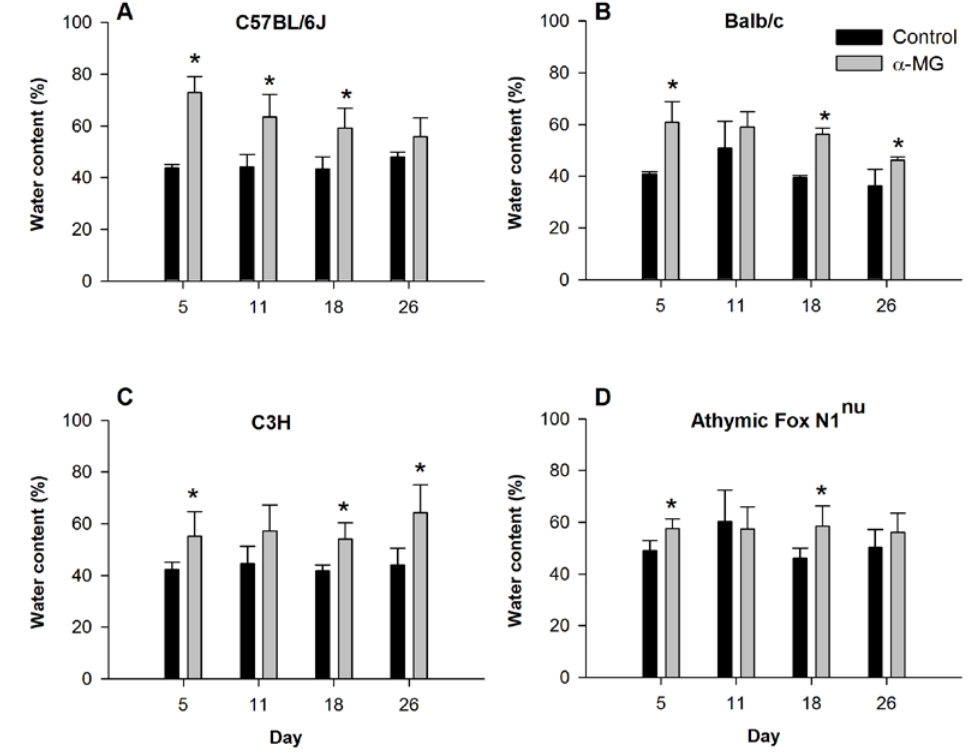
Figure 1. Dietary α-mangostin increases fluid content in stool. Water content in stool excreted by ( A ) C57BL/6J; ( B ) Balb/c; ( C ) C3H; and ( D ) Athymic FoxN1 nu mice during feeding of control diet or diet with α-MG. Stool was collected on the indicated days after initiating dietary intervention. * p < 0.05 against control group. Data represent the mean (±SD) of values for 3–5 mice per group for each murine strain on indicated days of the study. 3.2. Colonic Epithelial Cell Proliferation and Immune Cell Infiltration are Stimulated by α-MG To assess epithelial cell proliferation, Ki67 + cells were quantified in the mid colon of C3H, Balb/c, and athymic FoxN1 nu , as well as in C57BL/6J mice to verify our previous observation with this strain [22]. There was a significant increase in Ki67 + cells in the mid colonic epithelium of all four strains of mice fed diet with α-MG compared to control animals (Figure 2A). Infiltration of CD3 + and F4/80 + cells, markers of T cells and macrophages, respectively, in the mid colon also was significantly increased in all four strains of mice fed diet with α-MG compared to control diet (Figure